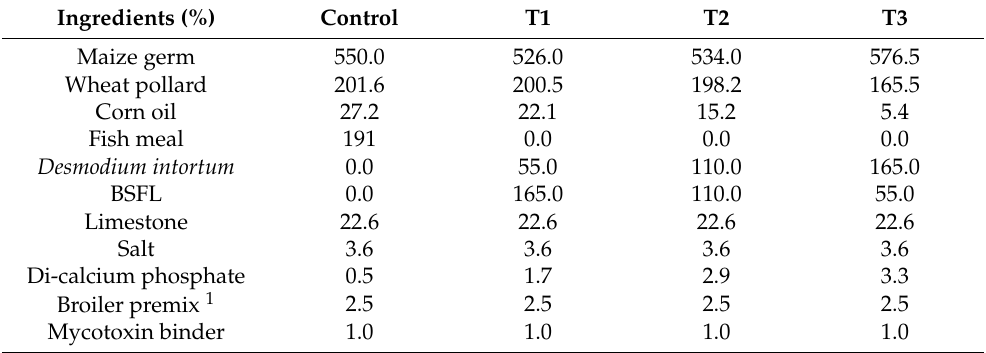
Table 3. Feed composition for Broiler starter finisher diets (Diets (g/kg) as fed) of Experimental